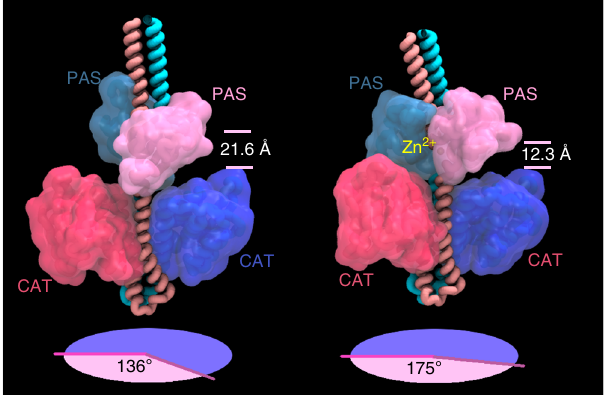
Fig. 5 Molecular modelling of WalK in the presence or absence of Zn 2 + . Still images taken from molecular dynamics simulation of full-length, membrane-bound S. aureus WalK in the a absence and b presence of Zn 2 + , showing the predicted conformational changes induced in the WalK Per- Arnt Sim (PAS) and catalytic (CAT) domain upon metal binding. Dihedral angles between the cytoplasmic PAS and CAT domains were measured over the course of the simulations (lower circular projections) and suggested that Zn 2 + binding directly in fl uences the relative positioning of the PAS and CAT domains. In the absence of Zn 2 + , the dihedral angle between the PAS CYTO and CAT domains in each monomer was ~136° when viewed down the central axis of the kinase, while the average distance between the upper and lower helices of the cytoplasmic domains was 21.6 Å. In the presence of Zn 2 + , this angle changed to ~175° and the average distance between the upper and lower helices contracted to 12.3 Å